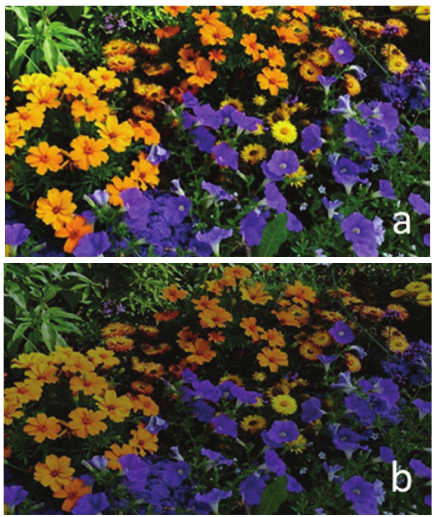
Figure 7: Effect of neutral density filter transmittance on the referenceimage:(a)referenceimageand(b)referenceimageaffected by neutral density filter transmittance